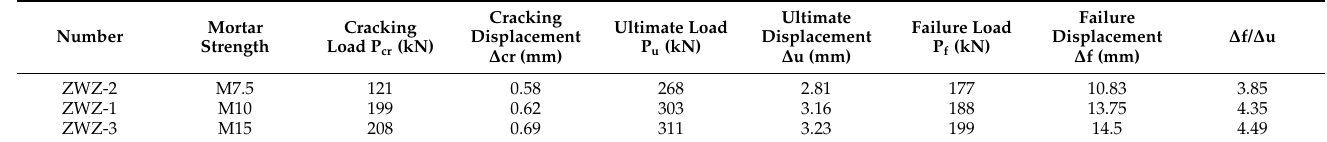
Table 7. Bearing capacity values of the walls with different mortar